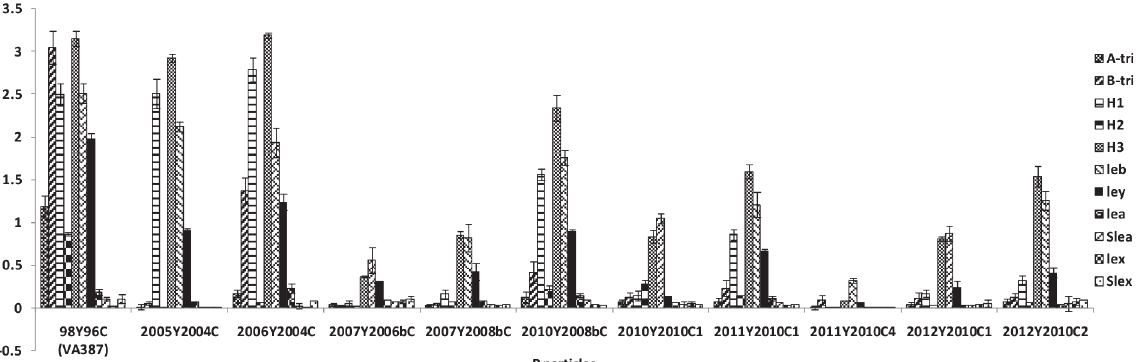
Fig 4. Binding of GII.4 P particles to synthetic oligosaccharides. P particles from 11 strains of GII.4 viruses (2005Y2004C, 2006Y2004C, 2007Y2006bC, 2007Y2008bC, 2010Y2008bC, 2010Y2010C1, 2011Y2010C1, 2011Y2010C4, 2012Y2010C1, and 2012Y2010C2) were coated onto 96-well plates at 2 μ g/ ml, and then incubated with oligosaccharides (H type 1, H type 2, H type 3, A, B, Le b , Le y , Le a , Le x , Sialyl-Le a , or Sialyl-Le x ) overnight. The y-axis indicates captured HBGAs detected by HRP-avidin (optical densities at 450 nm were averaged from at least two independent experiments), and the 98Y96C (VA387) P particle was set as the positive control for